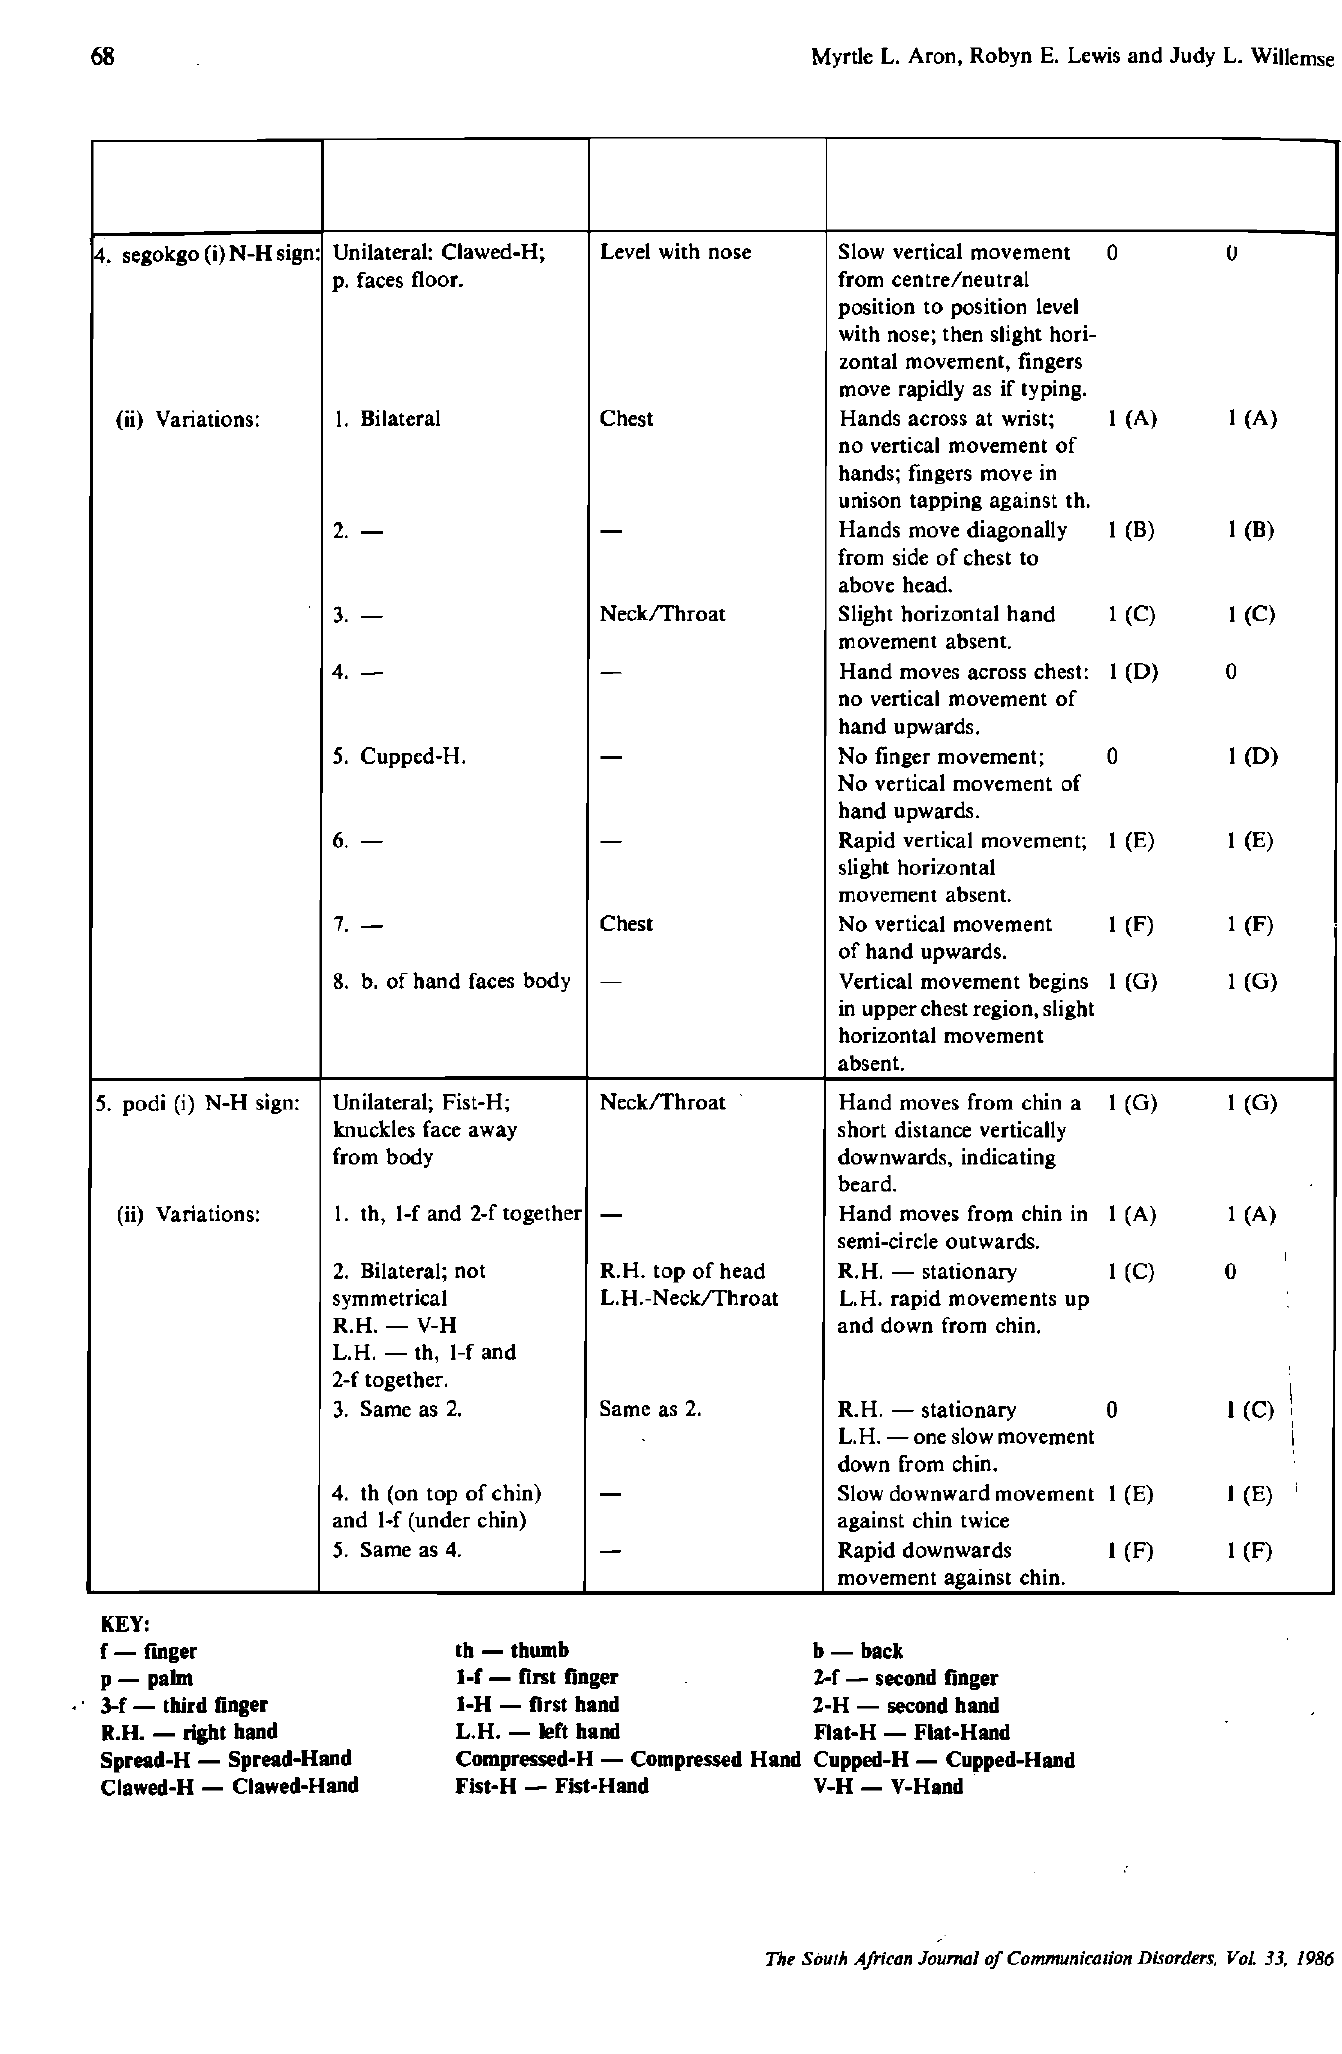
Level with nose Slow vertical movement from centre/neutral position to position